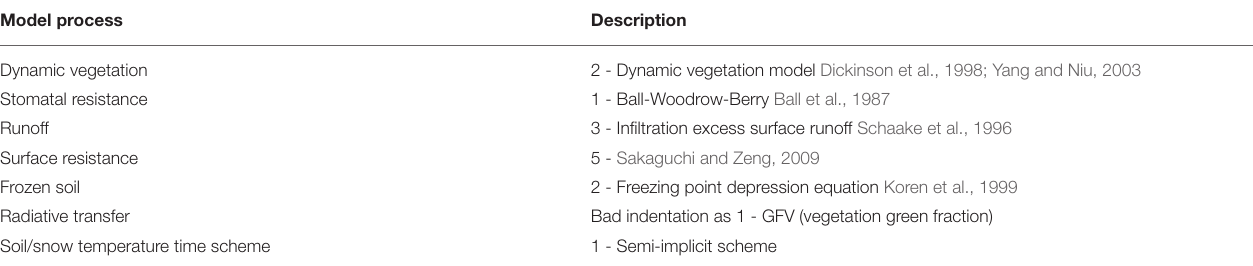
TABLE 2 | Selected physical options for the Noah-MP land surface model. Model